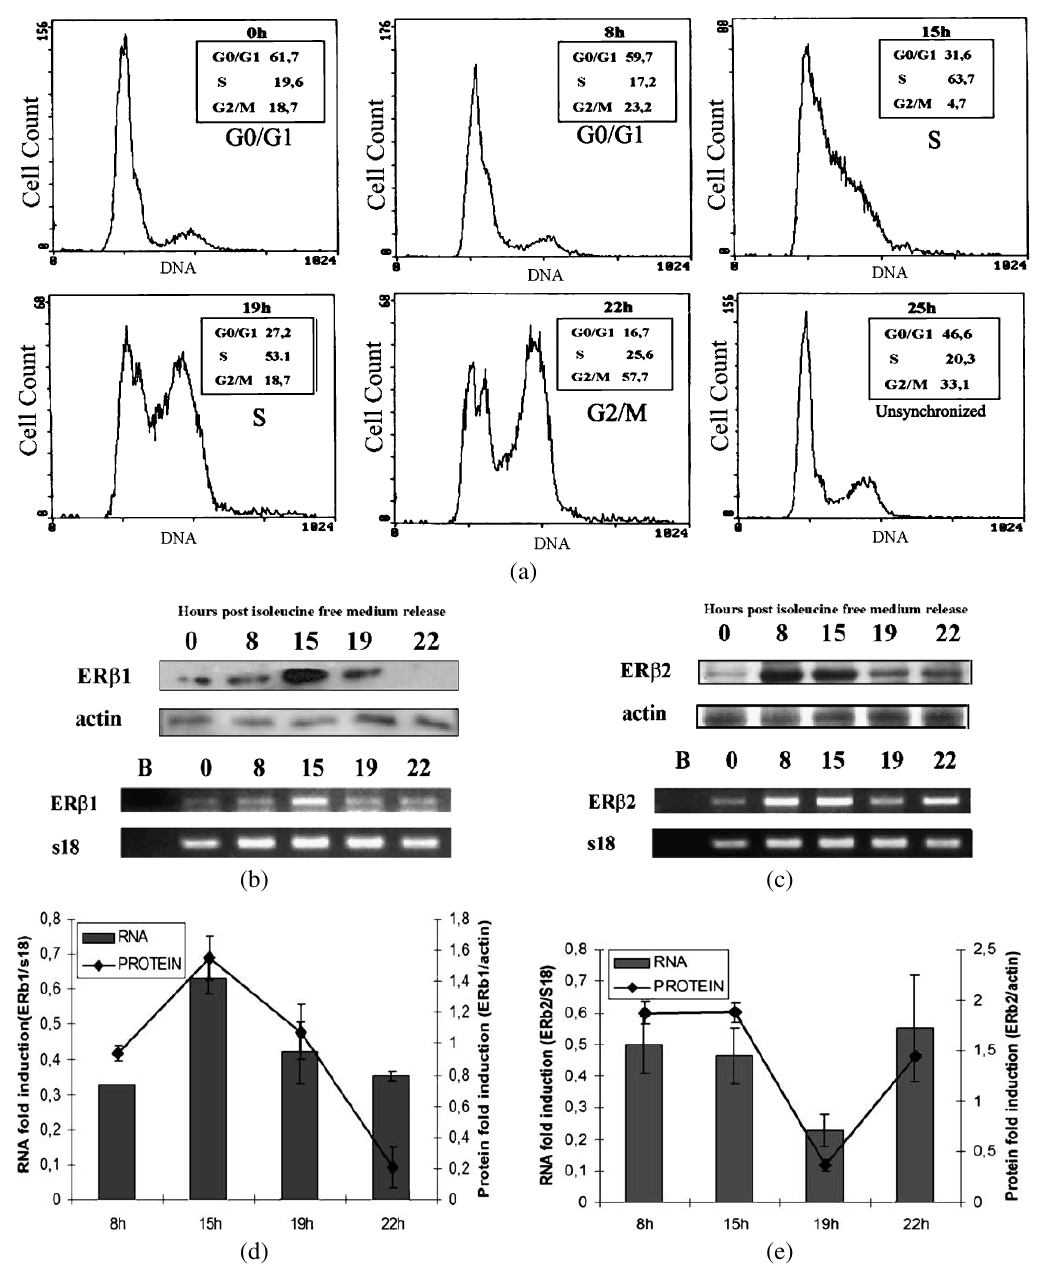
Fig. 3. ER β protein expression during cell cycle progression in synchronized LNCaP cells. (a) Graphic representation of cell cycle histograms showing the percentage of LNCaP cells harvested at 0 h, 8 h (G0/G1 phase), 15 h (early S phase), 19 h (late S phase) and 22 h (G2/M phase). (b and c) ER β 1 and ER β 2 protein (upper panel) and mRNA (lower panel) expression analyzed by western blot and RT-PCR, respectively. This method confirmed the results obtained by FACS and allowed a more accurate analysis of the changes in expression through cell cycle. (d and e) Graphic representation of ER β 1 (d) and ER β 2 (e) mRNA and protein levels after normalization with S18 and actin,